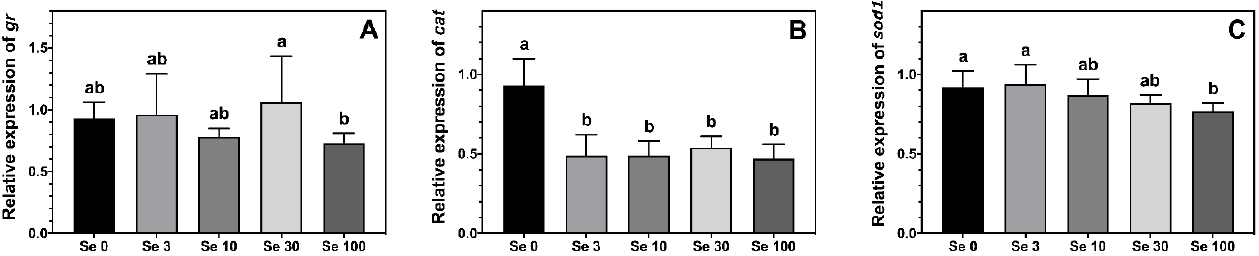
Figure 3. Expression levels (means ± SD, n = 6) of antioxidant enzymes gluthatione reductase, gr (A); catalase, cat (B) and superoxide dismutase 1, sod1 (C) measured by real-time PCR. Data were normalized to a geometric mean of ef1a and bactin and are presented as fold-changes of mRNA abundance compared with Se0. One-way ANOVA on ranks followed by Tukey’s HSD postdoc test was used to detect significant differences as displayed through uncommon superscript